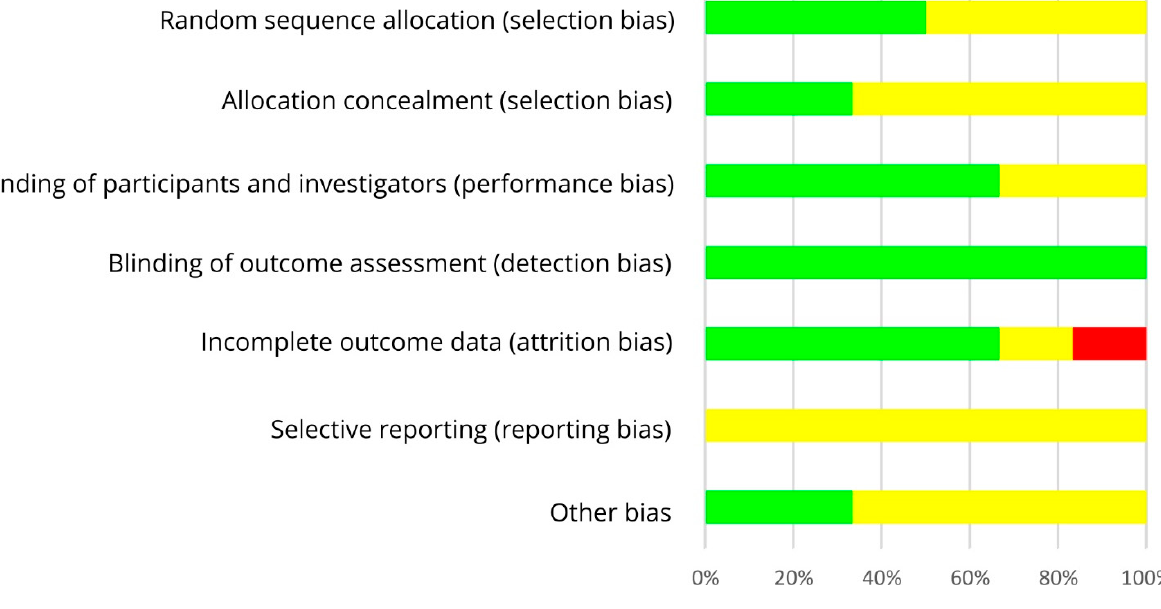
Figure 5. Risk of bias summary across studies with postmenopausal women. Green (+), low risk of bias; yellow (?), unclear risk of bias; red ( − ), high risk of bias .